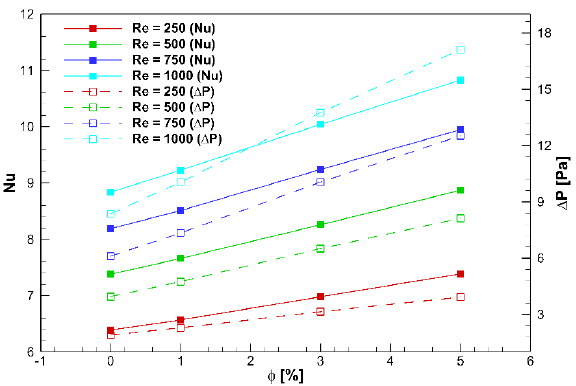
Figure 13. Variation of Nusselt number and pressure drop in terms of volume concentration at four Reynolds number obtained from the current optimized dimensions ( H = 45 mm and D = 22.5 mm).